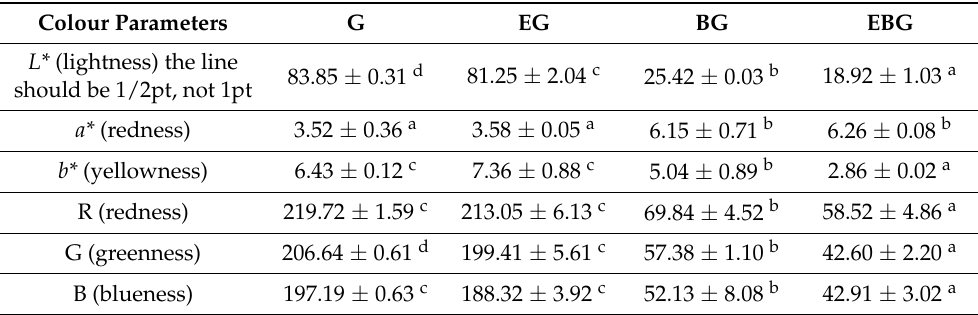
Table 3. Colour parameters in L*a*b* and RGB space obtained using the instrumental method (“electronic eye”) in white and black, conventional and organic garlic. Colour Parameters